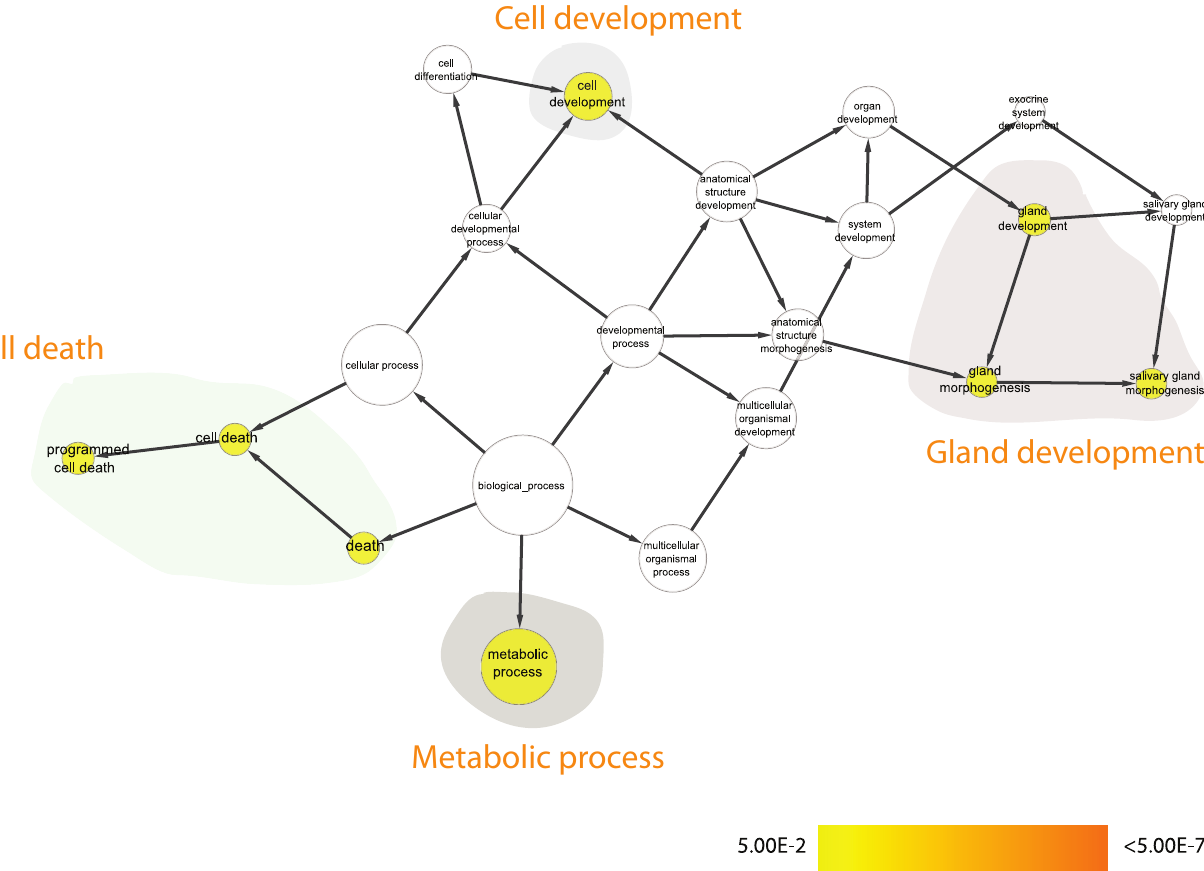
Figure 4. GSEA for the 391 Btk-dependent transcripts during Fly neuronal development: Enriched Biological Process clusters within the list of 391-transcripts (Btk-dependent transcripts during fly neuronal development). Figure 4 should be statistically interpreted as follows: The nodes, corresponding to different Gene Ontology clusters, are either not colored (white) i.e. not found with statistical power or colored in the scale yellow to orange, where yellow nodes are found with statistical significance after Bonferroni correction p , 0.05 and orange colored nodes are found to be even more statistically significant after correction, with a p , 7*10 2 8 . The grey-zoned data highlights statistically enriched clusters of nodes (genes/ transcripts), which all are represented under the manually designated heading e.g. ‘Gland development’ or ‘Cell death’. Due to space limitations in the main figure (Figure 4) we are not able to list the genes belonging to each grey-zone and cluster. This information is instead found in the Figure